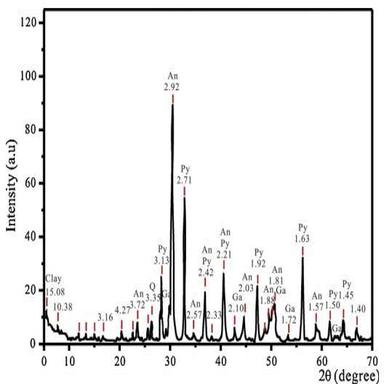
XRD diagram of the tailing waste deposit Gornje Polje: Py-pyrite, An-ankerite, Ga-galena.